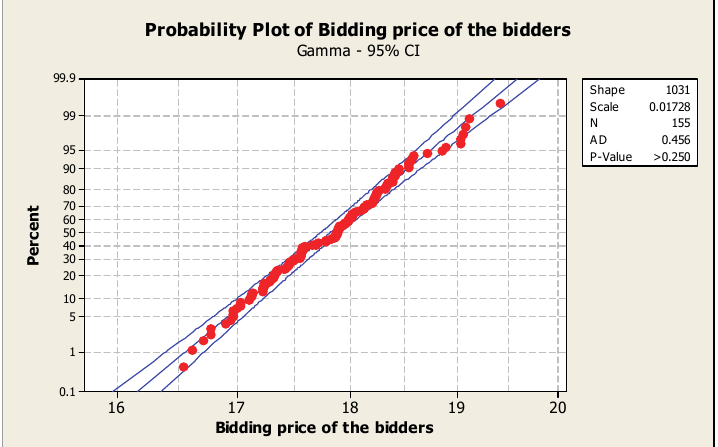
Fig. 7. Probability plot for the bidders' bid